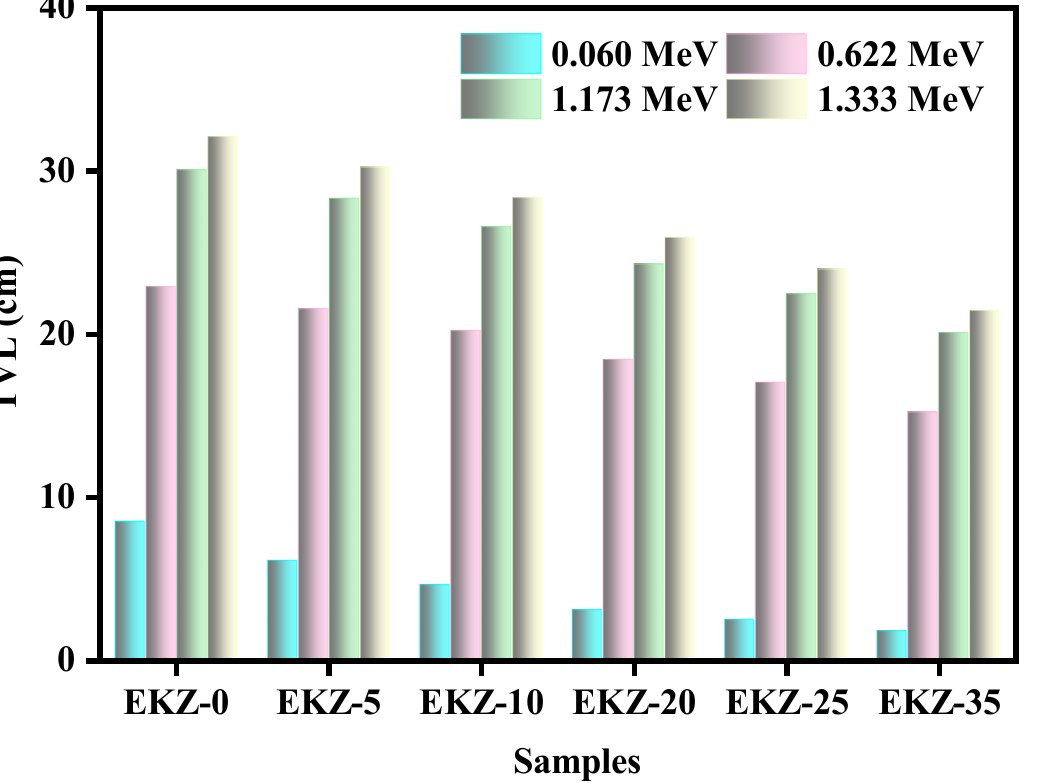
Figure 8. The TVL of EKZ samples as a function of photon energy. Figure 9 shows the radiation protection efficiency (RPE) of the EKZ samples as a function of the incoming photon energy. For all four tested energies, the RPE values increase with increasing ZnO content, which is especially evident at 0.060 MeV. At this energy, the RPE values are equal to 41.9% for EKZ-0, 53.1% for EKZ-5, 63.4% for EKZ-10, 77.9% for EKZ-20, 84.7% for EKZ-25, and 92.7% for EKZ-35. The same trends can be observed for the other three energies, although the difference between the values is much smaller. The figure also shows that the RPE of any single sample decreases with increasing energy. For instance, EKZ-5’s RPE decreases from 53% to 14% for the energy 0.060 MeV to 1.333 MeV, respectively, while EKZ-25’s RPE decreases from 85% to 17% at the same respective energies. Therefore, higher energy photons have an easier time penetrating through the samples, although increasing the ZnO content in the samples improves their shielding